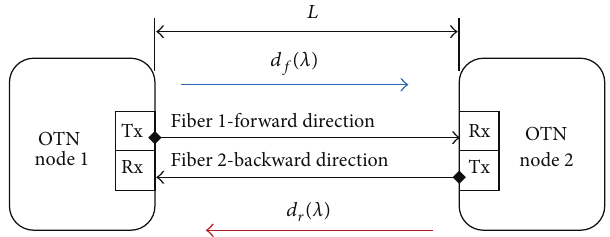
Figure 3: Packet signal transmission over optical fiber